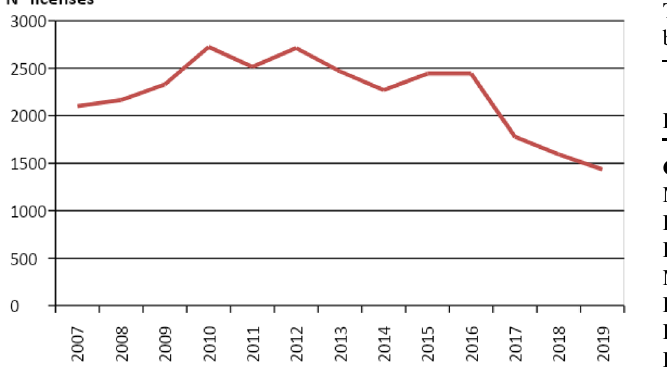
Fig. 2. Trend in the number of spear fi shing licenses from 2007 to 2019.